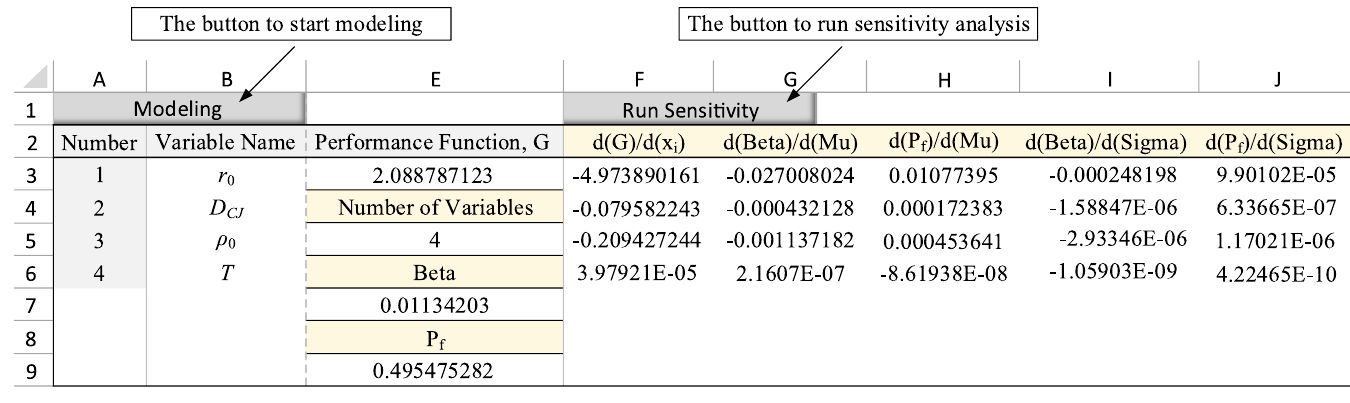
Fig 4. The output table in the spreadsheet for the example